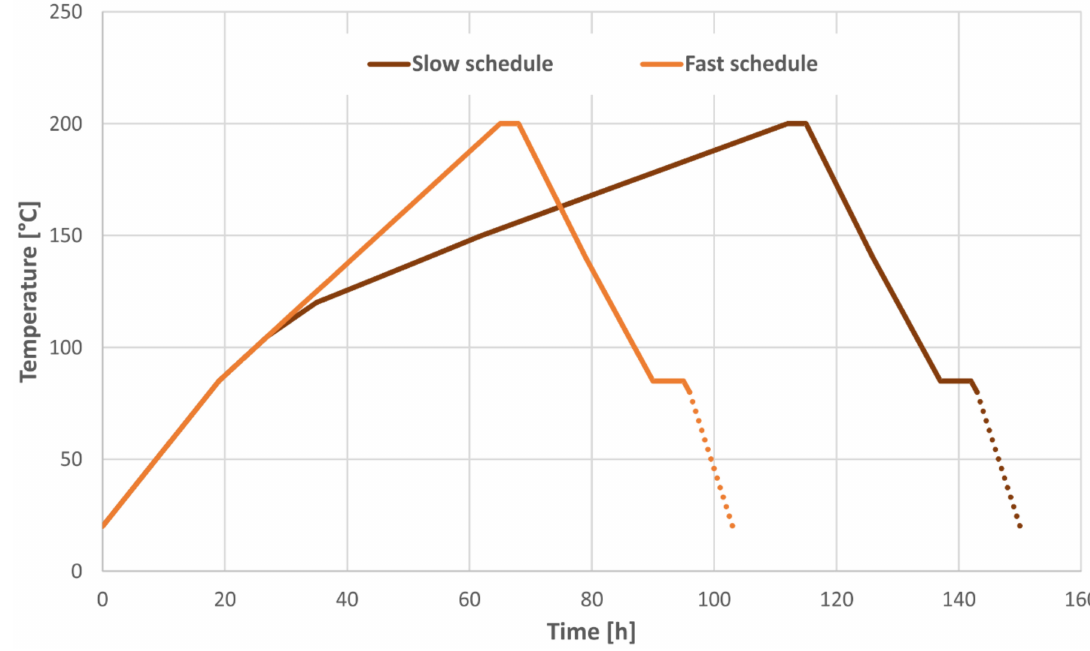
Figure 2. Phases of Slow and Fast thermal modification